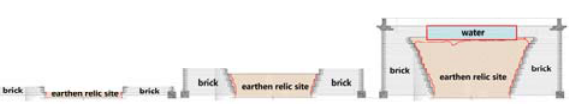
Figure 5. The stretch map for construction with rammed earth